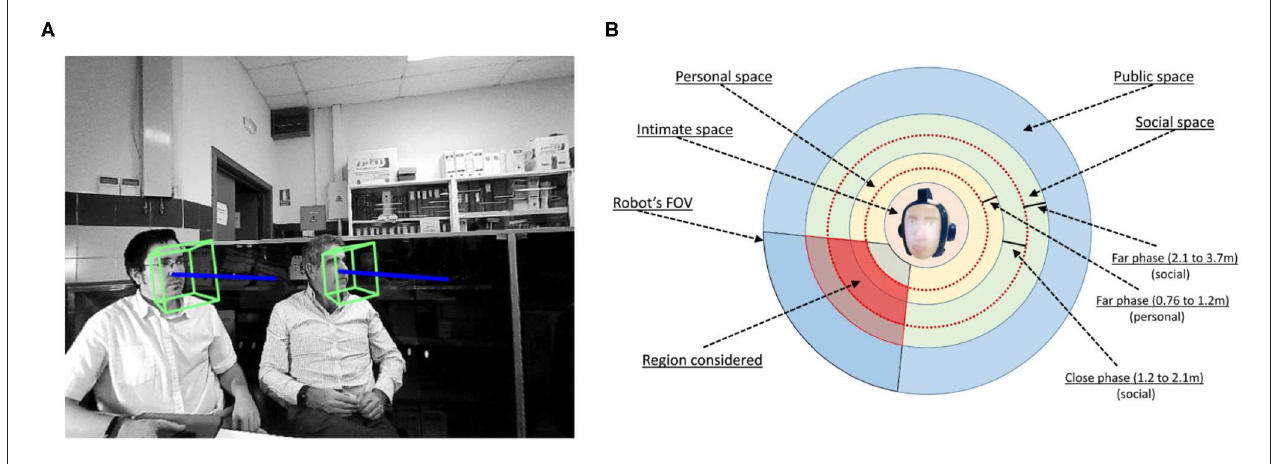
FIGURE 4 | VFOA and proxemic. (A) VFOA of two people. (B) Considering region in the proxemic approach.